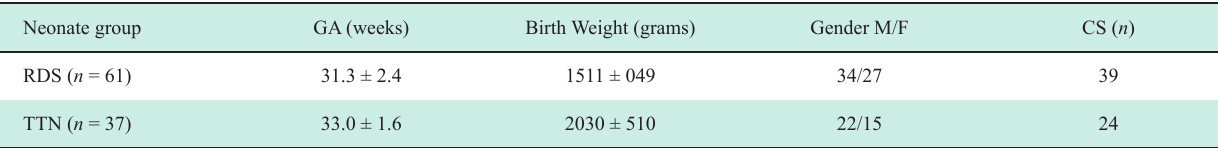
Table 1 General information about patients in two